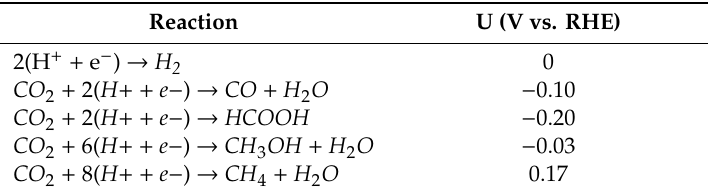
Table 1. Overall reactions for CO 2 reduction to different products and their equilibrium potentials (U, V vs. RHE) [45].